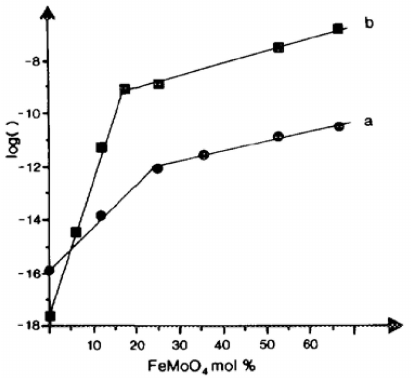
Figure 12. ( a ) Log rate of acrolein formation in propene oxidation on Bi 2 Mo 3 O 12 :Fe x Co 1 ´ x MoO 4 (0.043:1) at 380 ˝ C; ( b ) log σ of Fe x Co 1 ´ x MoO 4 solid solution vs. its iron molybdate content. Reproduced from [72] Copyright 2015, Elsevier BV.